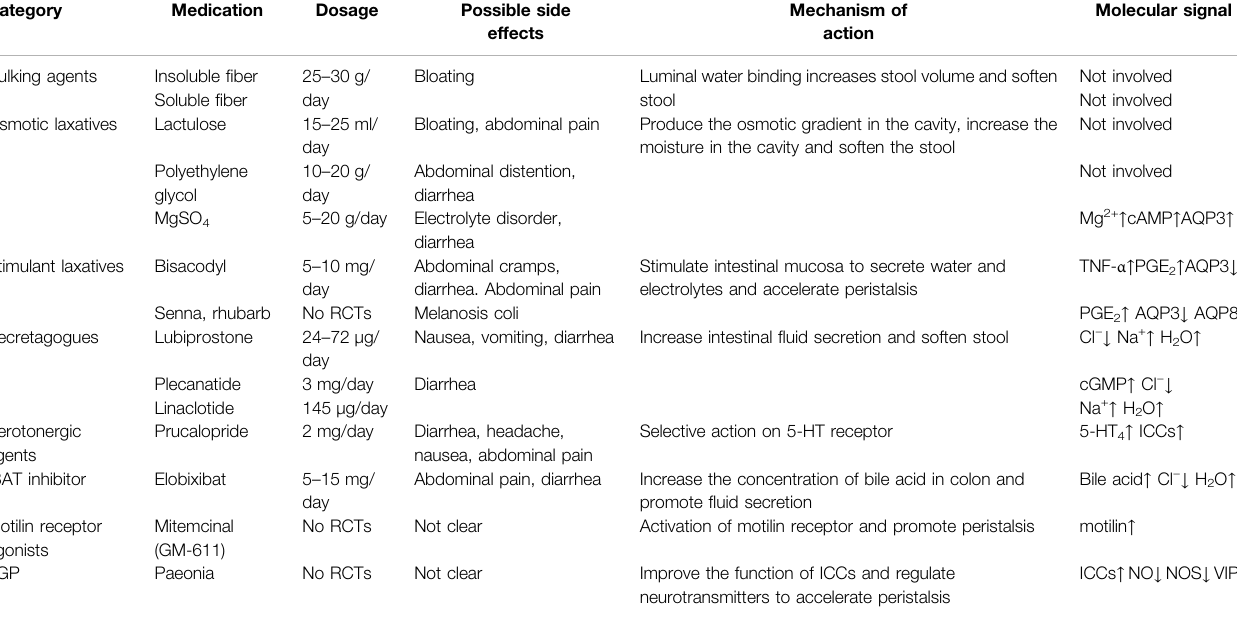
TABLE 1 | Summary of drugs for the treatment of